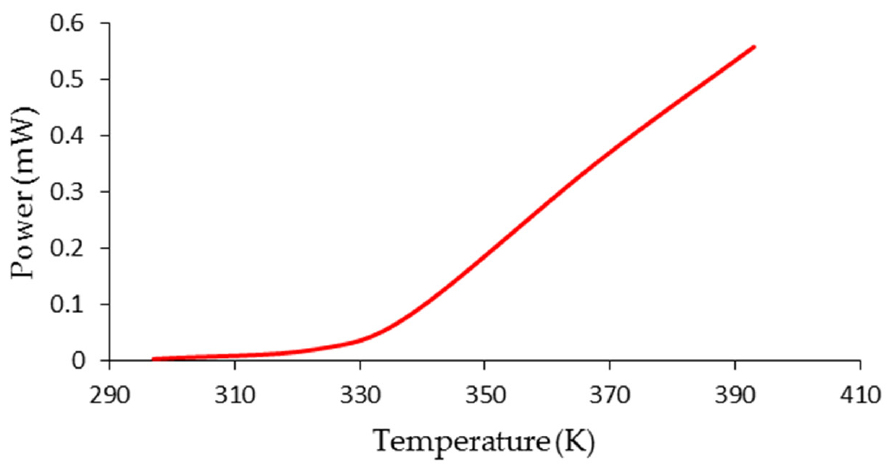
Figure 6. Output power of the thermoelectric generator.